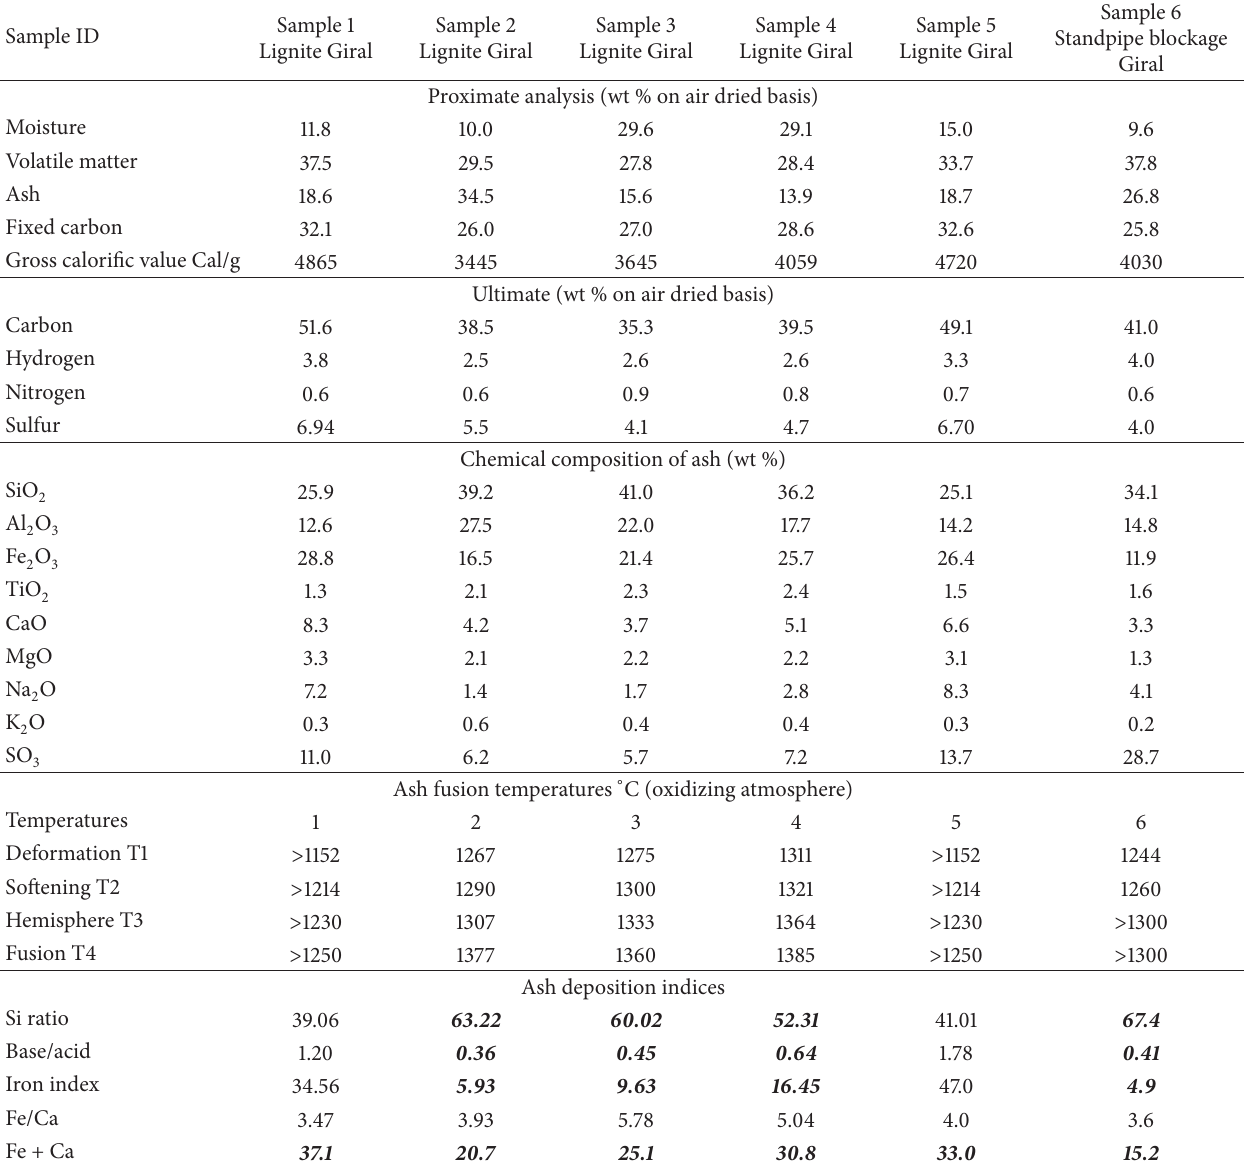
Table 1: Proximate, ultimate, chemical composition of ash, ash fusion temperatures, and ash deposition indices of high sulfur lignite.